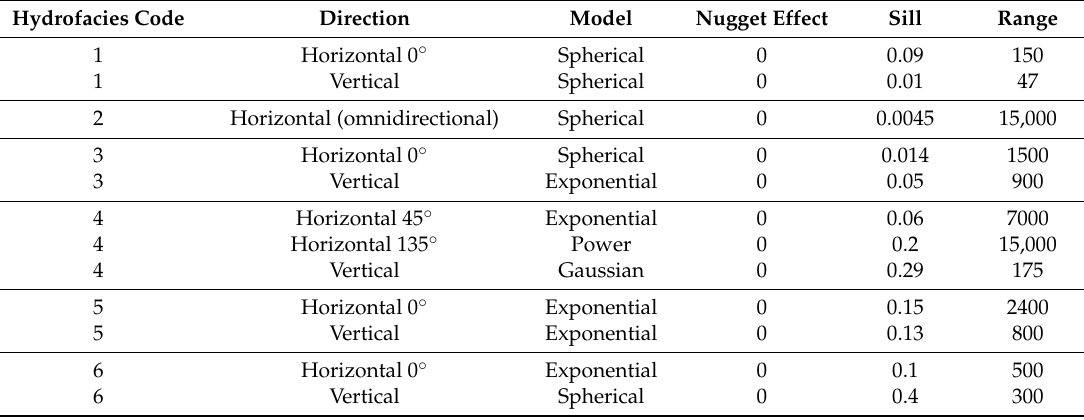
Table 2. Experimental variogram model parameters. Hydrofacies codes: 1. Aeolian and dune sands; 2. Silt basin: 3. Sand basin; 4. Marshlands clay; 5. Sand and gravels with clay; 6. Sand and gravels.